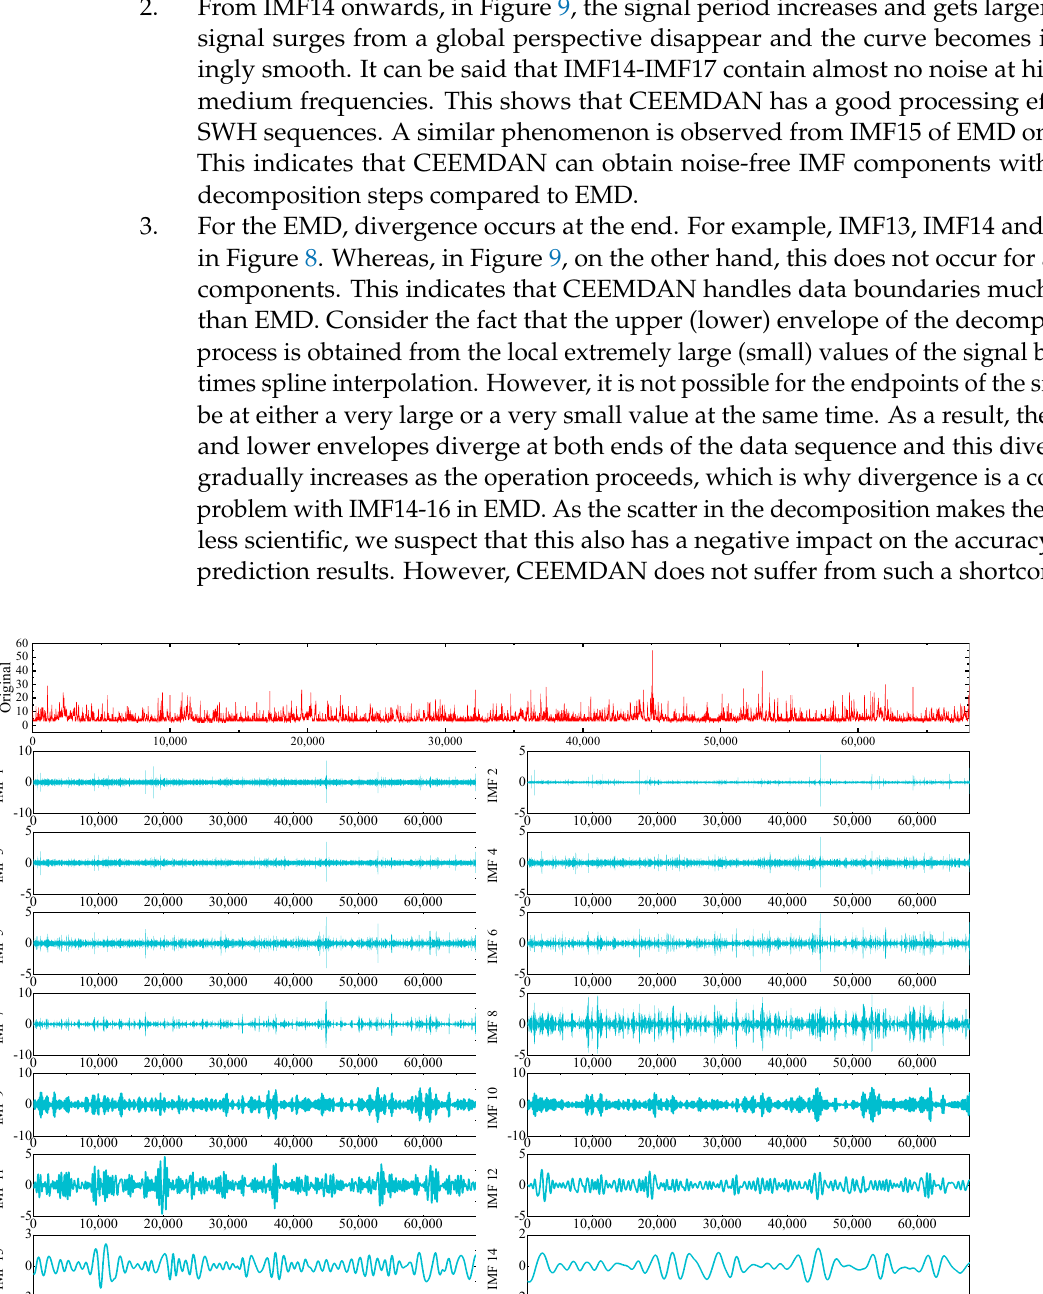
Figure 9. Comparison of ShiDao effective data in the time domain for the IMFs component of SWH sequence by CEEMDAN algorithm.